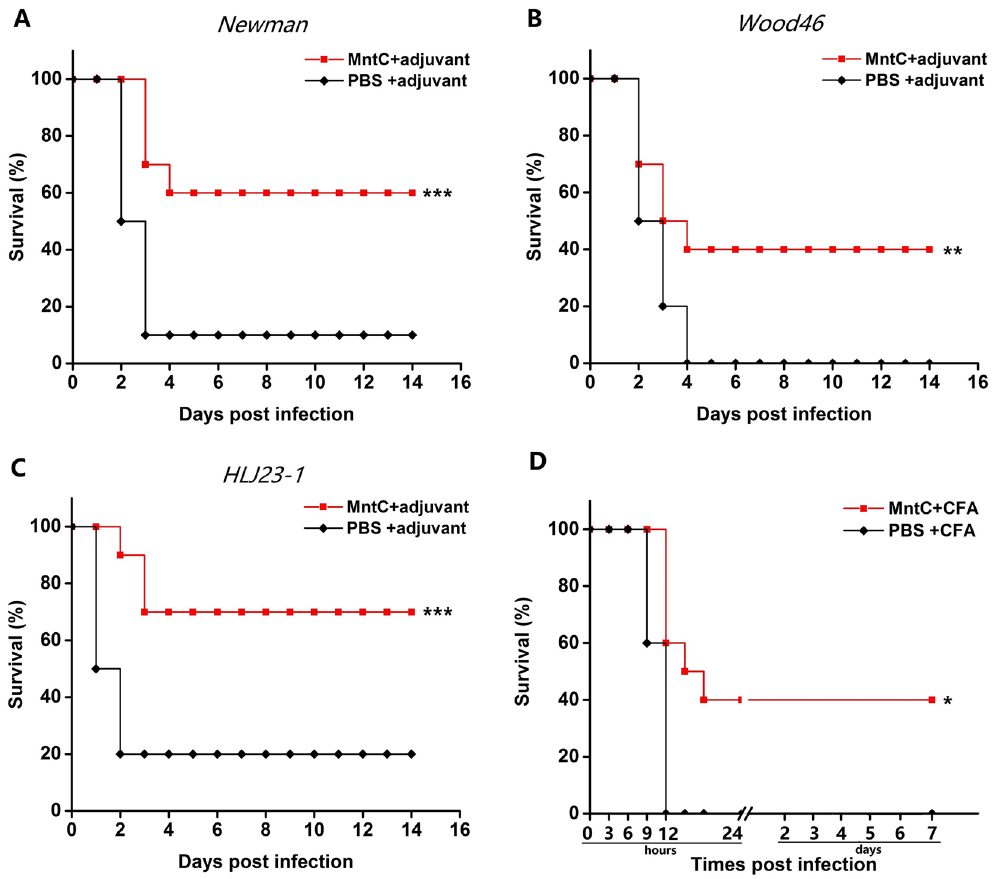
Figure 1. Validation of the protective efficacities in a lethal doses S . aureus peritonitis model. Female BALB/c mice (n = 10) were peritoneally challenged with ( A ) S . aureus Newman (8 × 10 8 CFUs), ( B ) S . aureus Wood46 (1 × 10 8 CFUs) and ( C ) S . aureus HLJ 23-1 (5 × 10 8 CFUs) after immunization. ( D ) Immunotherapy, MntC- vaccinated mice 1 h after S . aureus Newman (8 × 10 8 CFUs) infection. Survival rates were daily monitored and recorder for 14 days, and compared to animals treated with PBS. Significant differences were indicated by ( * P < 0.05), ( ** P < 0.01) and ( *** P < 0.001).